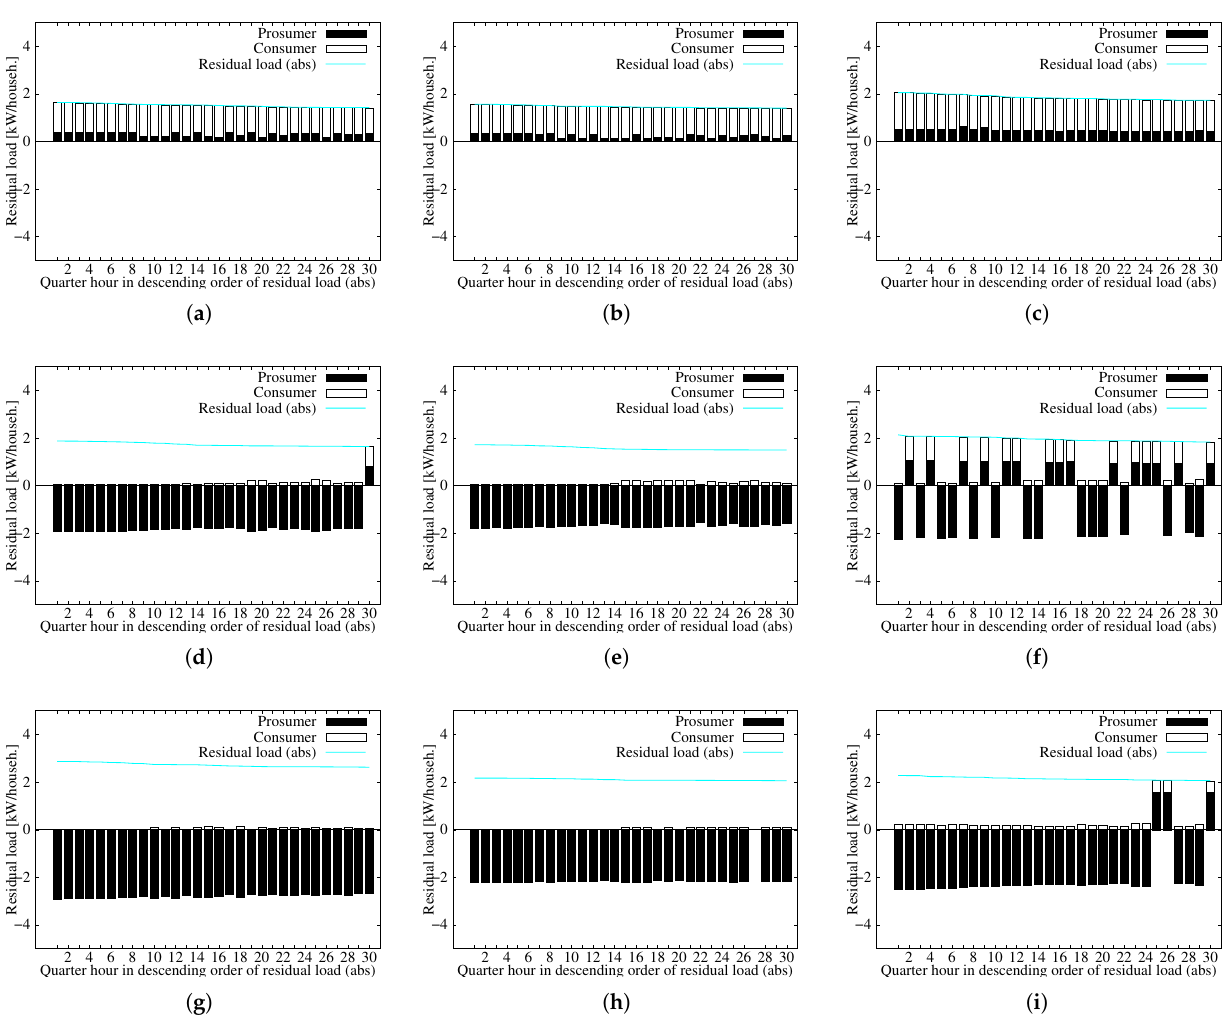
Figure 5. Residual loads at node, per household [kW] and in descending order of the absolute value of the residual load. All figures are for a distribution network of n = 49 households, i.e., σ = 7. ( a ) Battery mode 1 at a 25% pros. penetration; ( b ) Battery mode 2 at a 25% pros. penetration; ( c ) Battery mode 3 at a 25% pros. penetration; ( d ) Battery mode 1 at a 50% pros. penetration; ( e ) Battery mode 2 at a 50% pros. penetration; ( f ) Battery mode 3 at a 50% pros. penetration; ( g ) Battery mode 1 at a 75% pros. penetration; ( h ) Battery mode 2 at a 75% pros. penetration; ( i ) Battery mode 3 at a 75% pros.